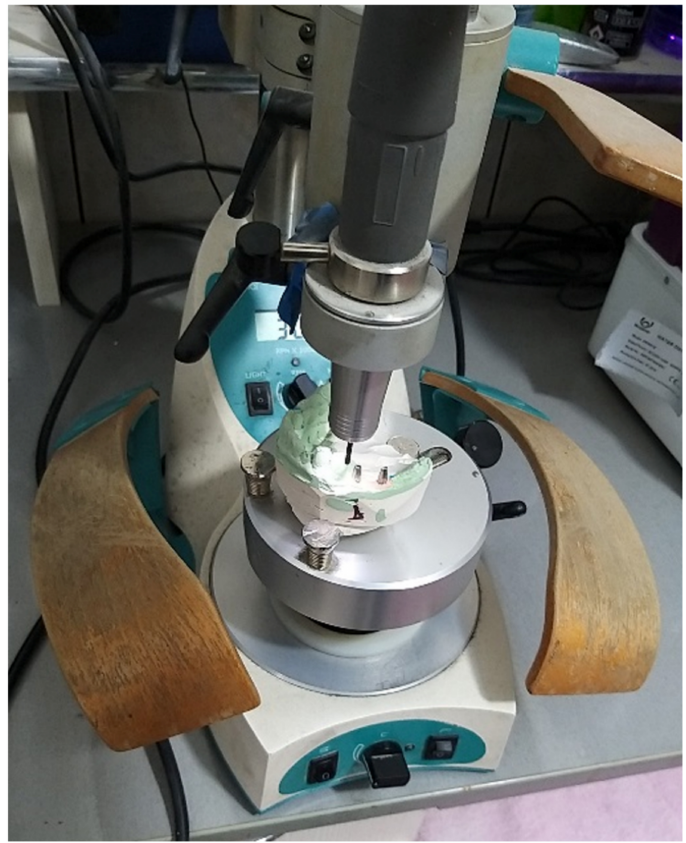
Figure 1. Standard abutment milling with Parallelograph Pi Dental.